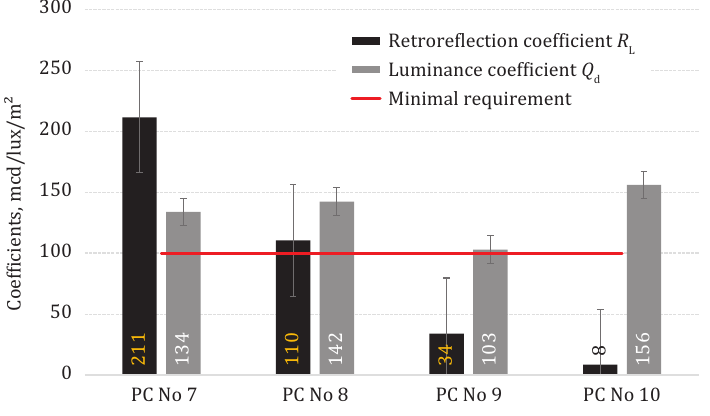
Figure 6. Average retroreflection luminance coefficients per crossing in